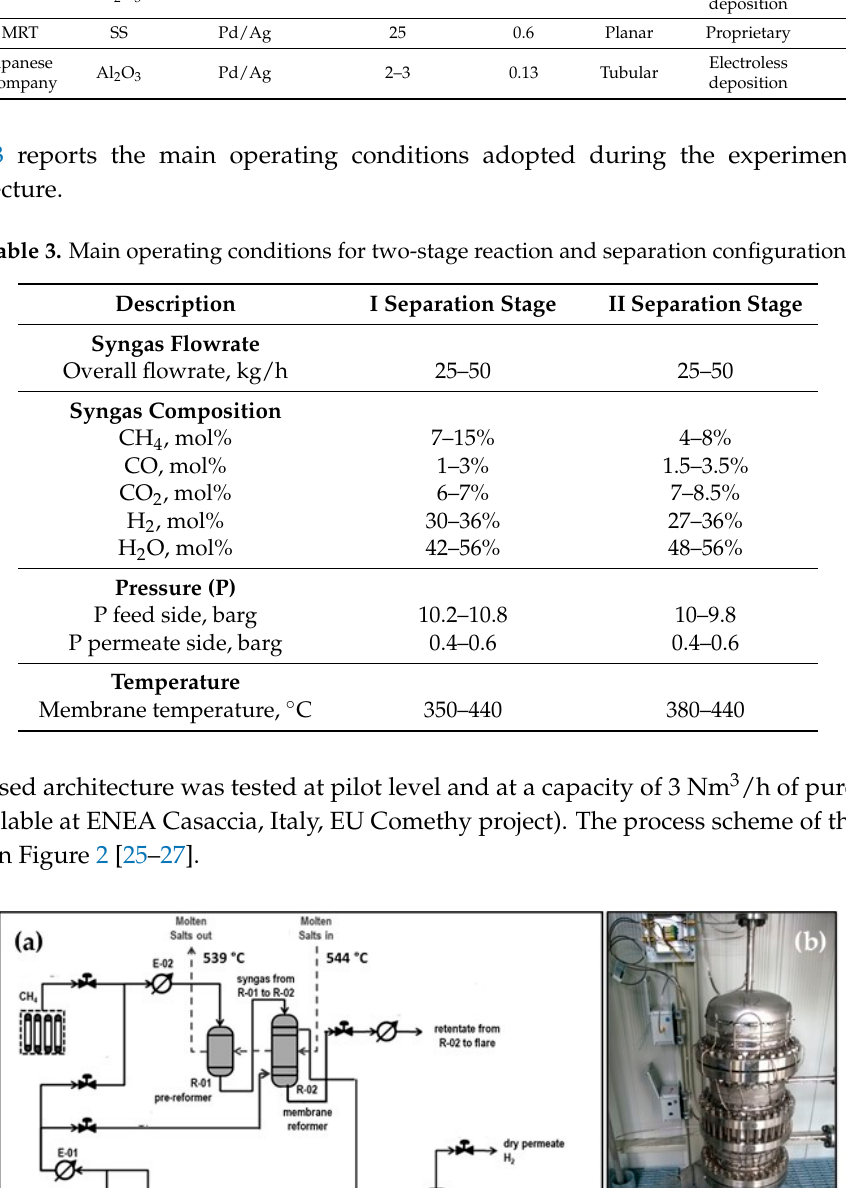
Table 2. Main characteristics of the employed membranes.